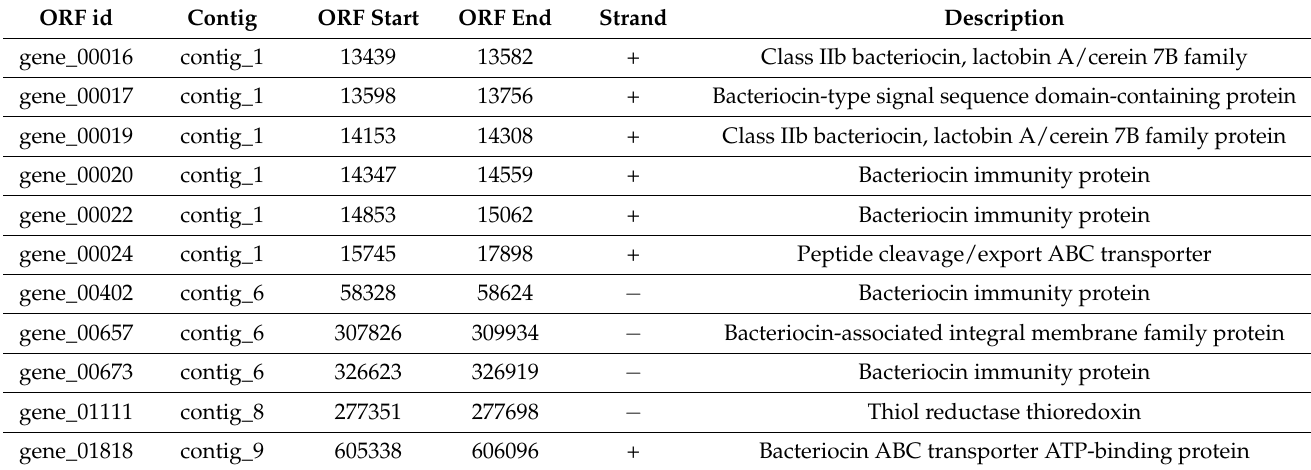
Table 1. Main genes related to bacteriocins present in the genome of S. downii .